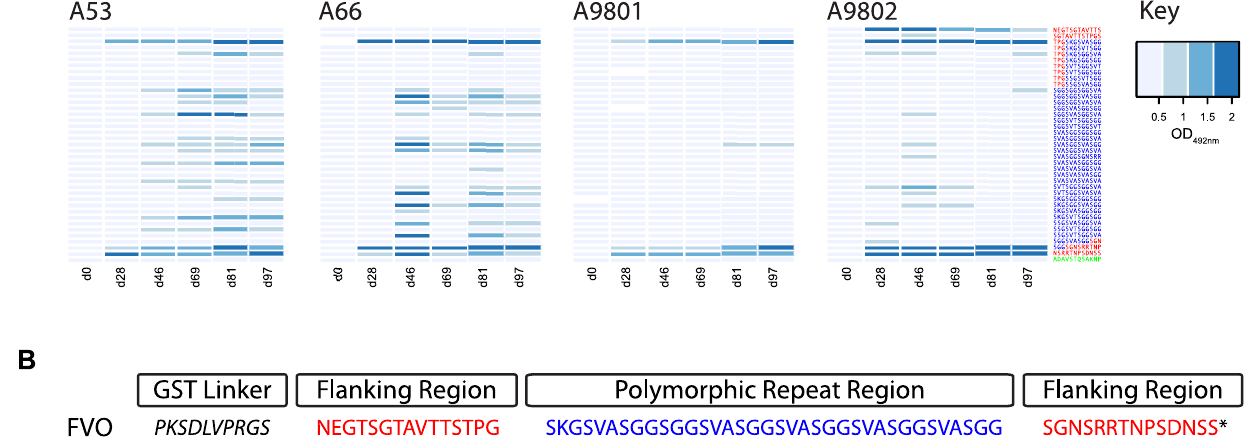
Figure 5. A. Heat map of antibody reactivity to FVO Block 2 serotype peptides over the course of immunization. MSP-1 Block 2 specific peptide ELISA is as described in Figure 4 and in Materials and Methods. Reactivities of sera from immunized Aotus are shown as blue rectangles for each peptide tested, with darker colored bars indicating higher ELISA reactivity as shown in the figure key. Columns represent serum reactivity for each time point, and each panel shows reactivity for all pre-challenge samples from each animal. B. Amino acid sequence of the FVO MSP-1 Block 2 antigen. MSP-1 Block 2 flanking sequences are shown in red and internal repeat sequences in blue, matching the peptide sequences shown in Panel A.